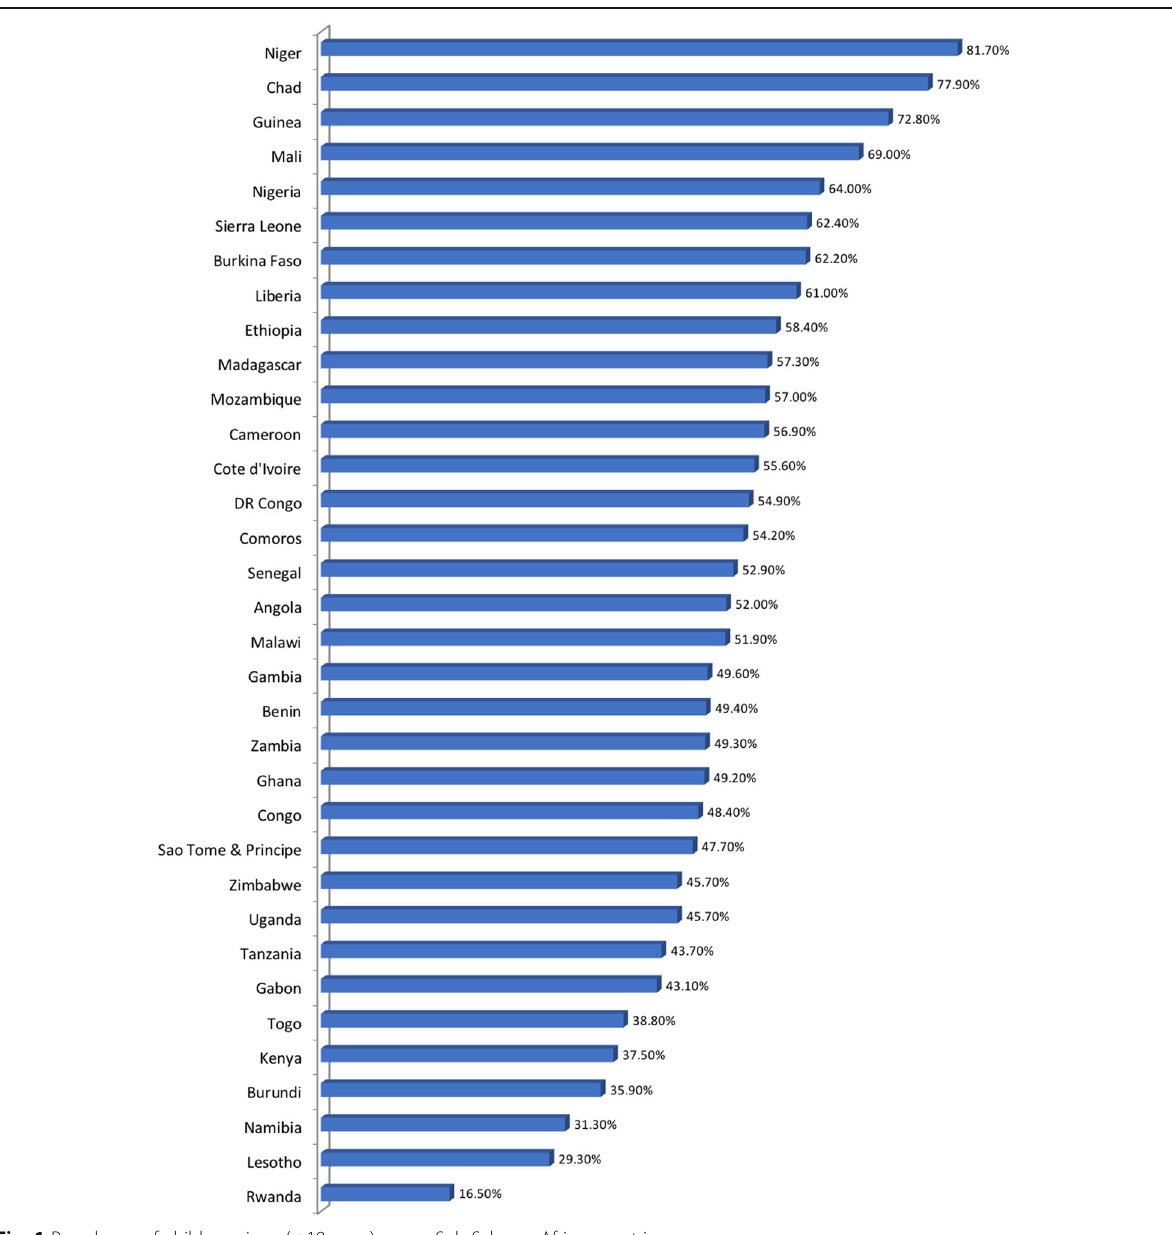
Fig. 1 Prevalence of child marriage (< 18 years) across Sub-Saharan Africa